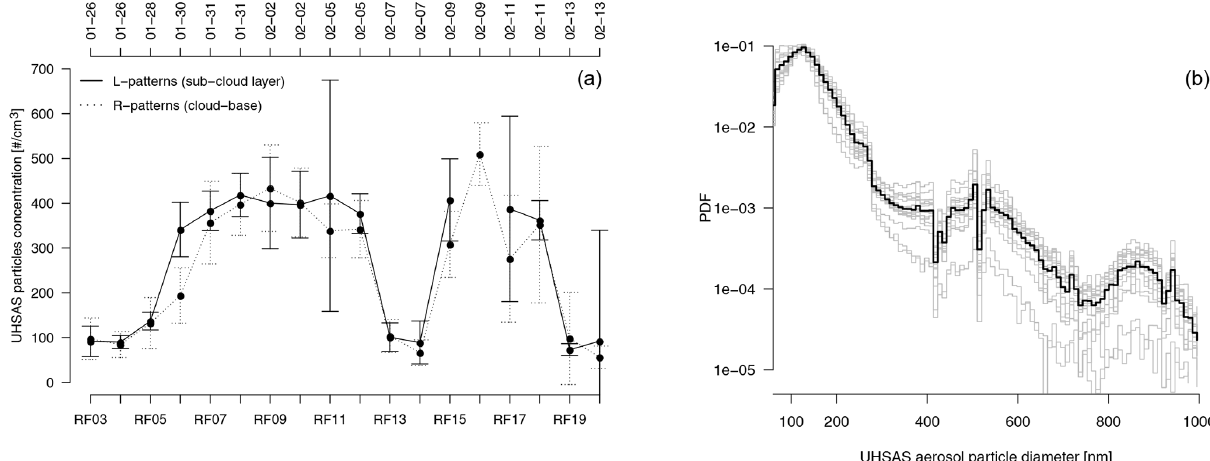
Figure 9. (a) Evolution of the total concentration of aerosol particles (cm − 3 ) within the subcloud layer and at the cloud base level derived from UHSAS data (vertical bars represent the standard deviation across the different R patterns or L patterns during each flight). Note that the time axis is not linear, and markers are only related by a line to ease readability. (b) Probability distribution function of the aerosol particle size derived from UHSAS data over the R patterns flown at cloud base; the mean of each ATR flight is shown in gray, and the mean over all flights is shown in